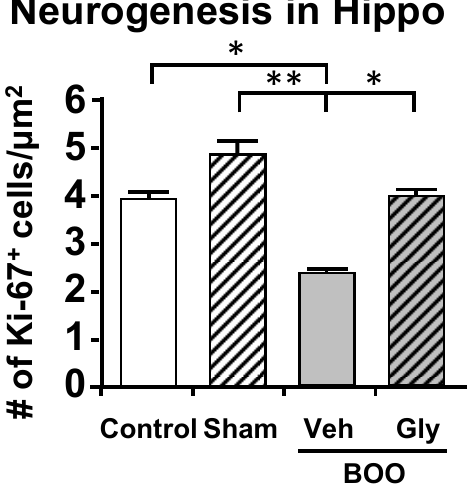
Figure 8. After 12 weeks of BOO, neurogenesis is statistically decreased in the hippocampus and this increase is blocked by glyburide treatment. Cells in 10 µ m sections of brain were stained for Ki-67 and then visualized and quantitated as described in the Materials and Method section. The results are presented as the density of Ki-67+ cells per µ m 2 . Veh = vehicle-treated, Gly = glyburide-treated. Results are the mean ± 95% confidence intervals; * p < 0.5 and ** p < 0.01 by ANOVA and Dunn’s test. ( n = 6, 6, 6, 6). This figured was reprinted, with permission from the Wiley Periodicals, from [9].